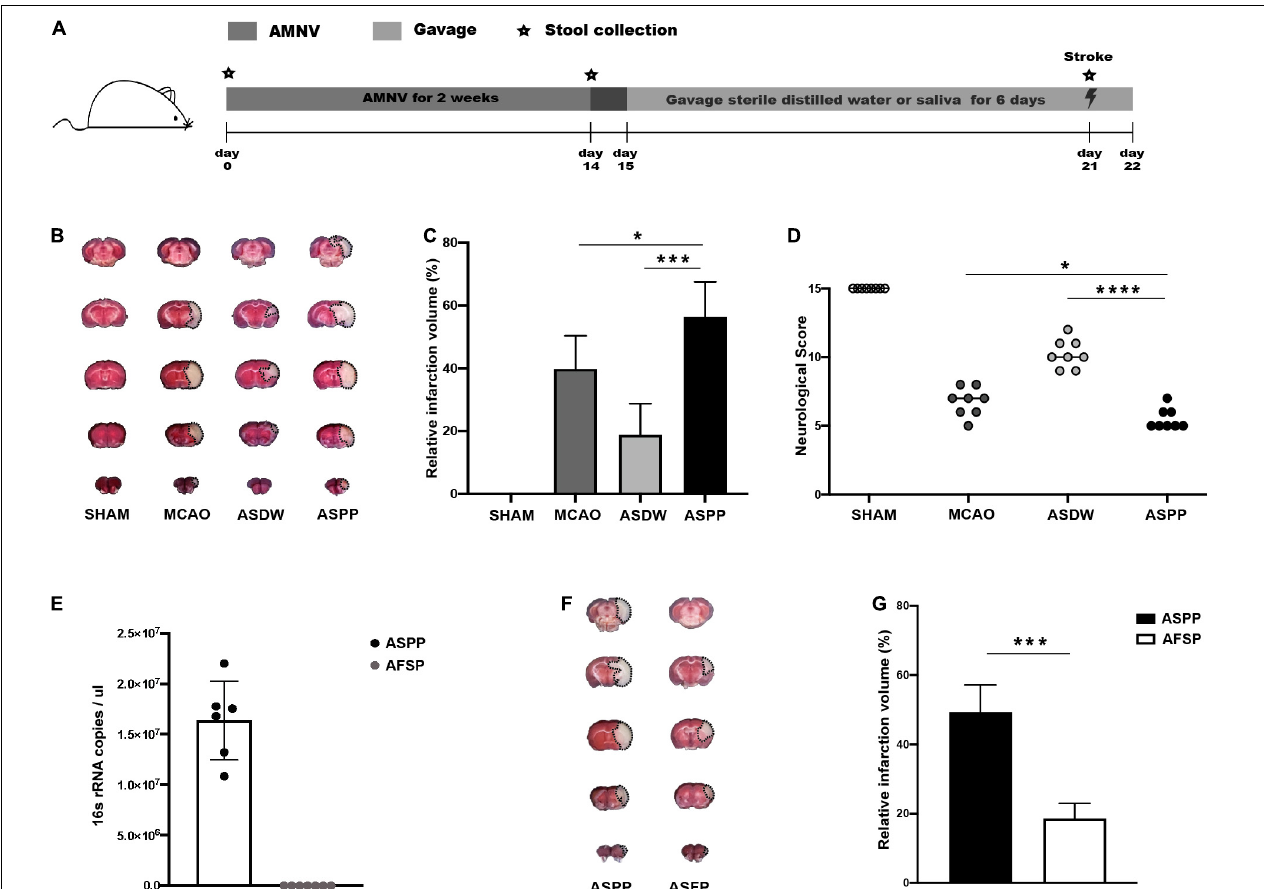
FIGURE 1 | Gavage of periodontitis salivary microbiota aggravates ischemic stroke in mice. (A) Experimental design for testing the effects of saliva of periodontitis patients. AMNV, ampicillin, metronidazole, neomycin sulfate, and vancomycin. (B) Representative TTC-stained images of mouse cerebral sections 1 day after stroke. TTC, 2, 3, 5-triphenyl-2H-tetrazolium chloride. MCAO, middle cerebral artery occlusion. ASDW, antibiotics + sterile distilled water + MCAO. ASPP, antibiotics + saliva of periodontitis patients + MCAO. (C) Quantification of infarct volume. n = 8:8. (D) Neurological scores of mice 1 day after stroke. n = 8:8:8:8. (E) qPCR analysis